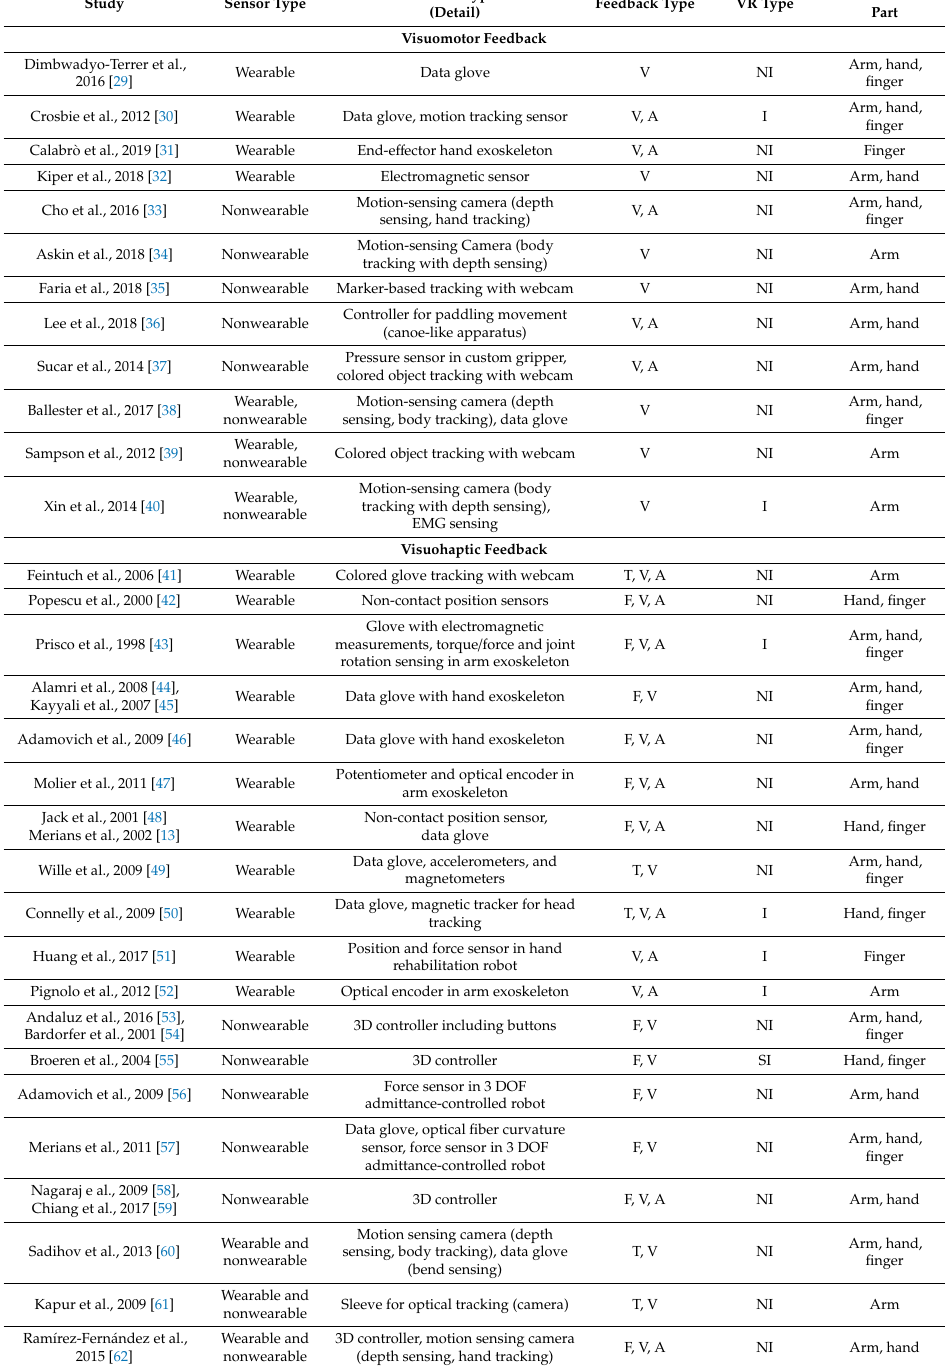
Table 1. Virtual rehabilitation studies for upper limb